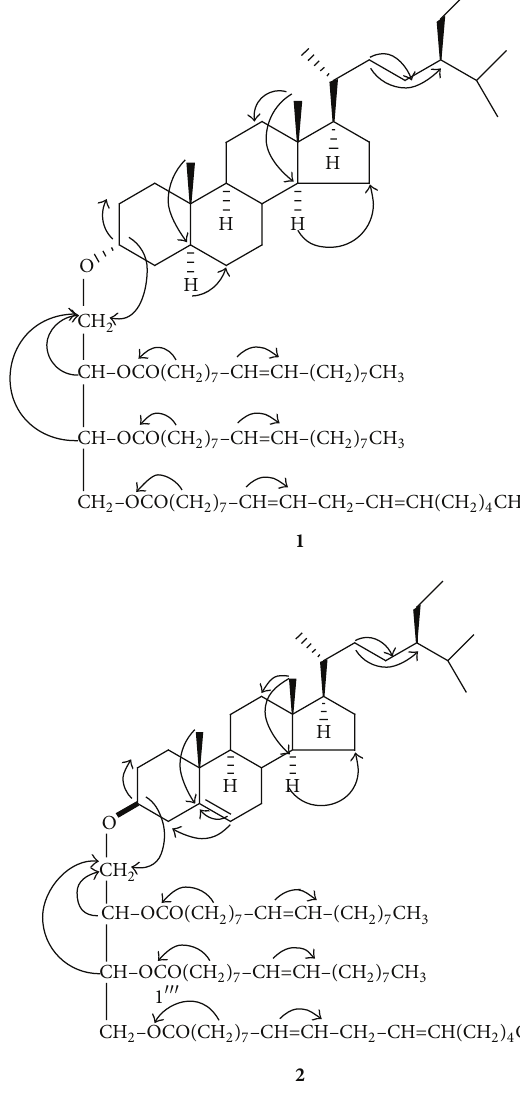
Figure 3: Key HMBC correlations of new compounds 1 and 2 .